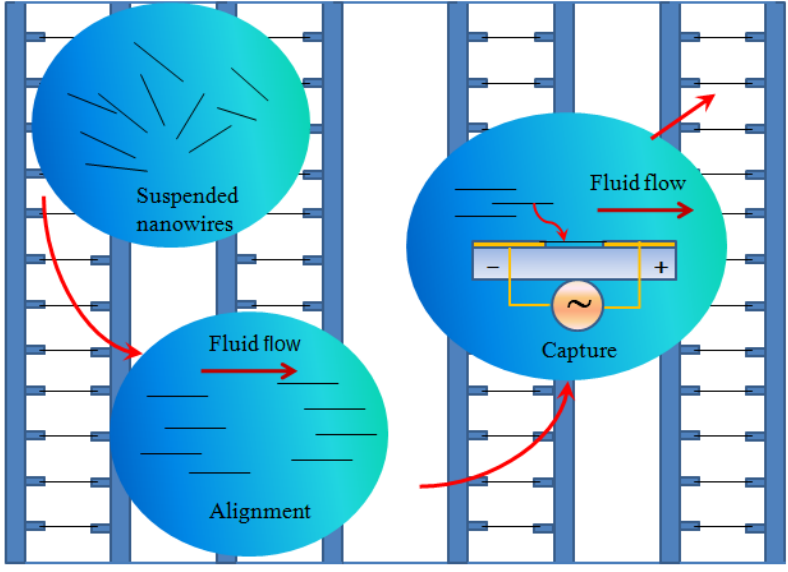
Figure 14. Nanowire self-assembly onto electrode arrays from solution. The foreground depicts a side view of fluid flow alignment of a colloidal suspension of nanowires that are subsequently trapped by dielectrophoretic forces between two opposite electrodes. The background illustrates a top view of the final array of assembled nanowires between electrode pairs (Reprinted by permission from [111]. Copyright 2010 Macmillan Publishers